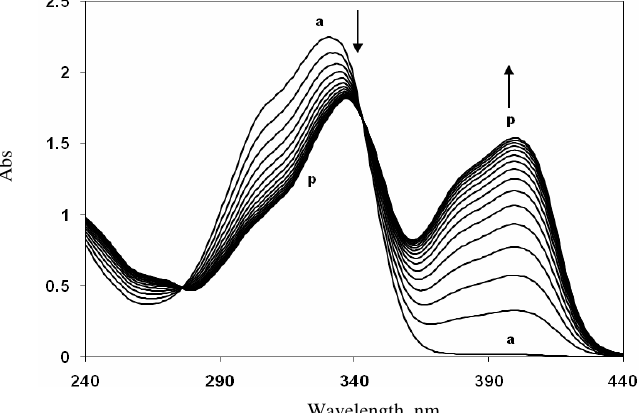
Figure 3. UV-Vis absorption spectral changes for 1.0 mM BDAP with UV irradiation in chloroform. From a to p, each irradiation time = 60 s; total, 900